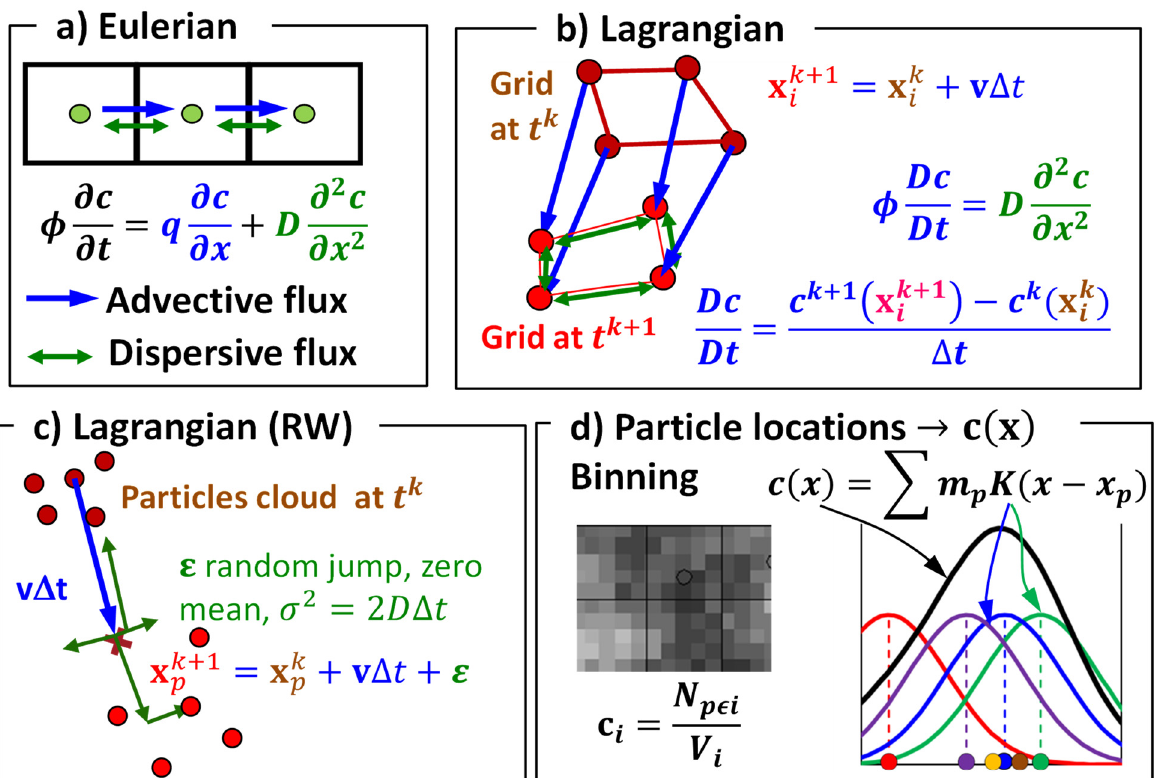
Figure 10. Schematic picture of ADE solution methods. Eulerian methods ( a ) work on fixed coordi- nates (accurate but possibly unstable). Lagrangian methods avoid most instabilities by working on moving coordinates, through ( b ) moving grids or ( c ) tracking particles (e.g., RW, where dispersion is reproduced by random displacements). Concentration can be obtained from particles locations ( d ) by binning, or averaging (“Bells” method).